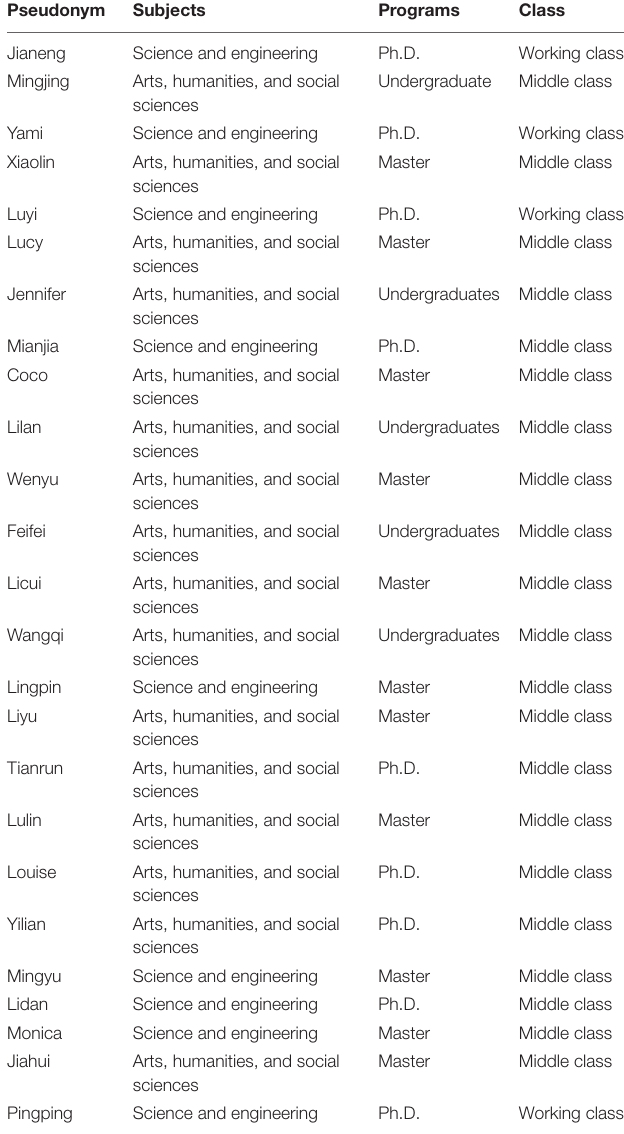
TABLE 1 | Profile of semi-structured interview